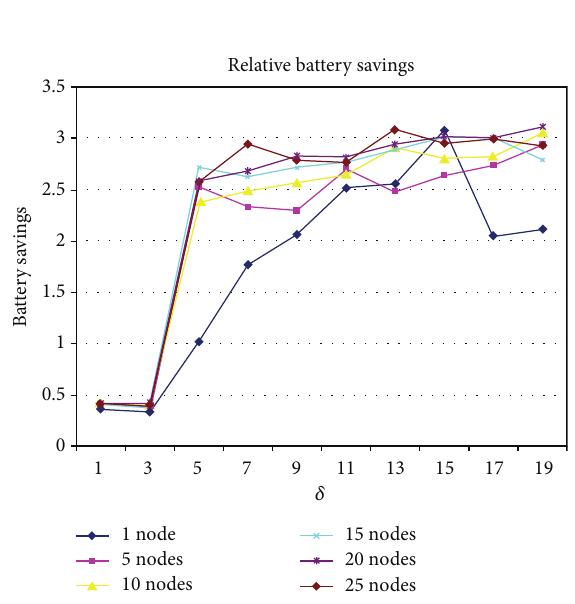
Figure 9: Relative battery savings.